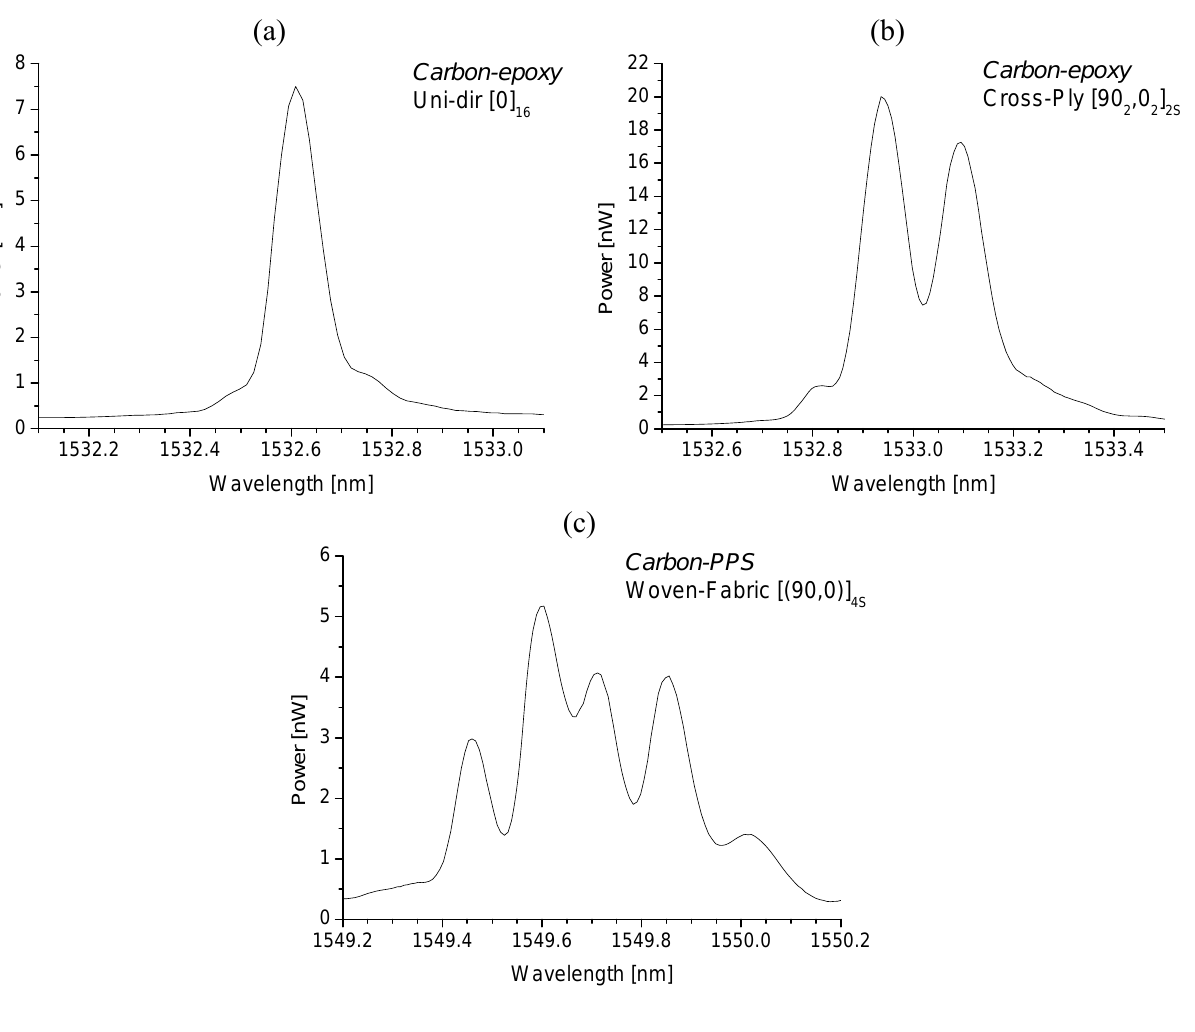
Figure 7. Spectrum of an uncoated FBG embedded (a) in a unidirectional laminate, (b) in a cross-ply laminate, (c) in a cross-ply woven fabric